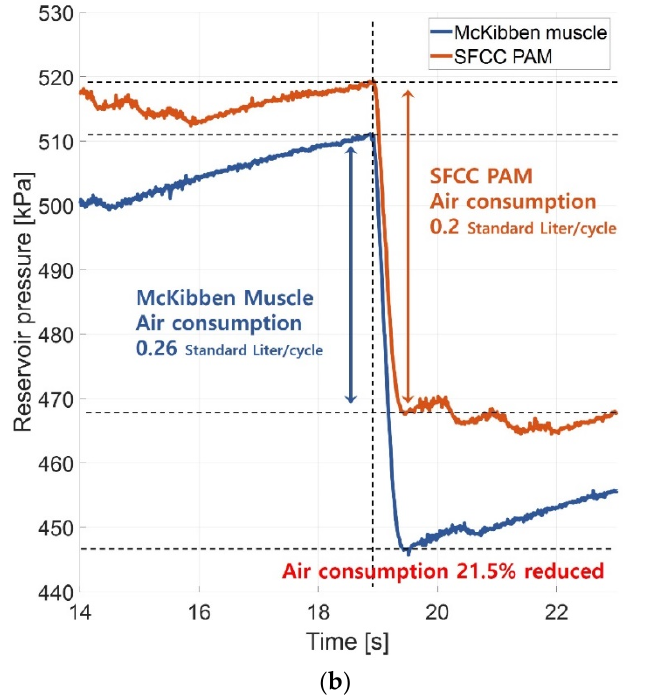
Figure 9. ( a ) Comparing the reservoir pressure reduction while the actuators conducting same task. ( b ) An enlarged graph of the black dot circle in ( a ) showing the air consumption in one cycle.